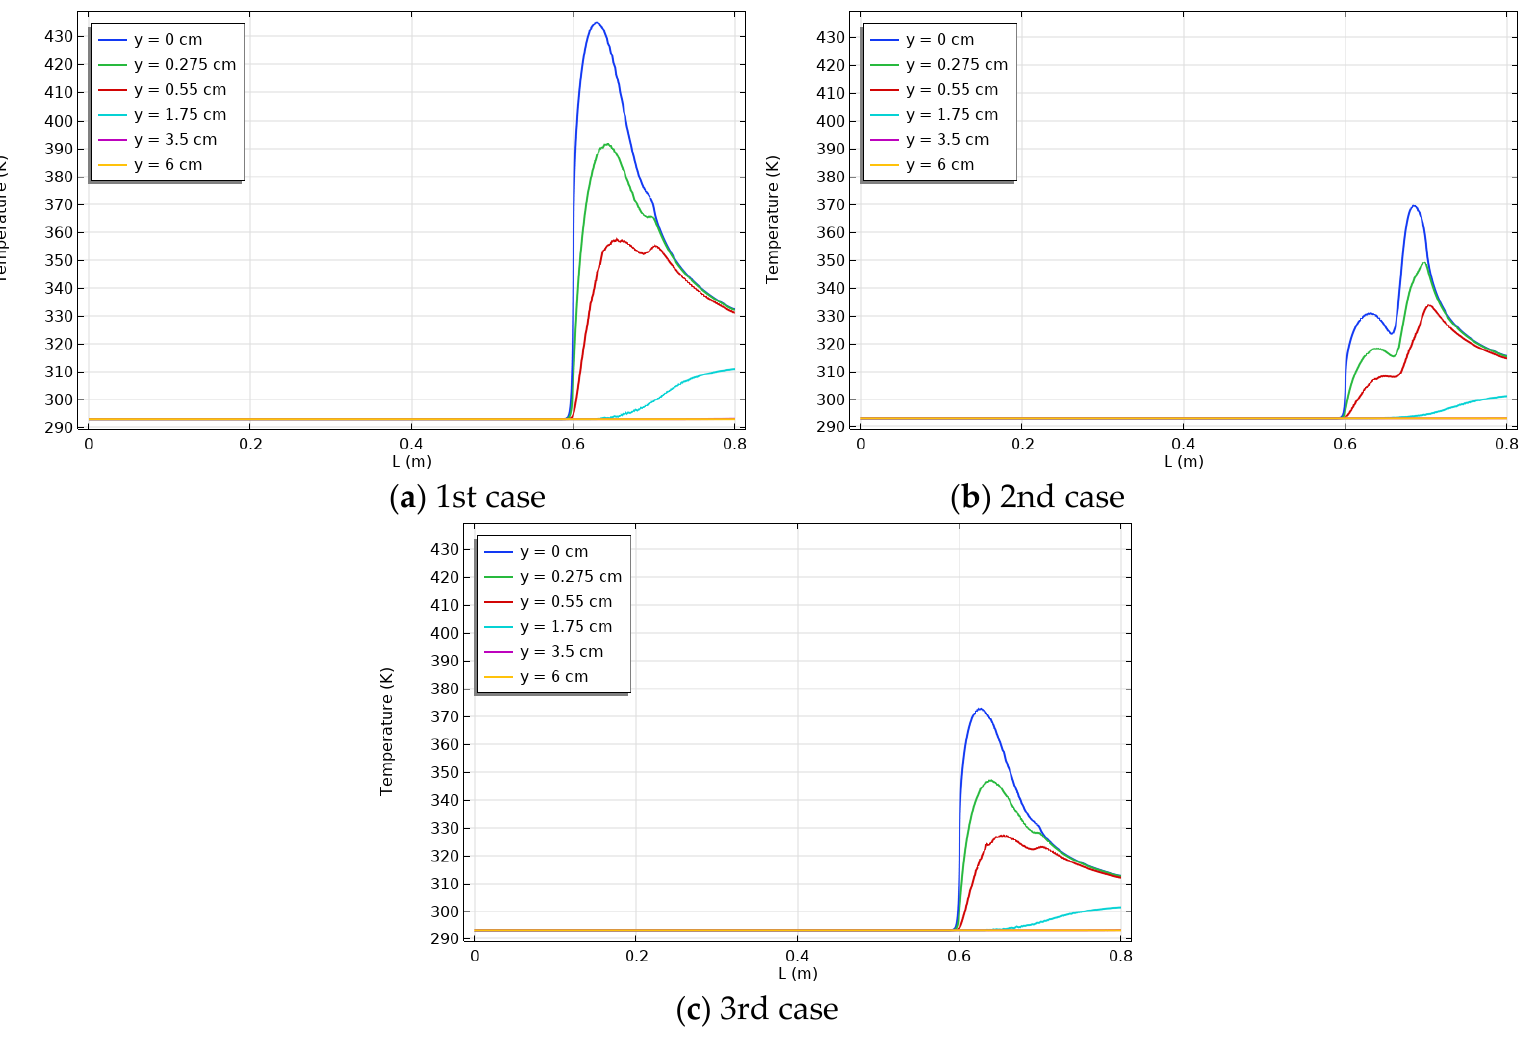
Figure 9. Temperature profile during the positive y axis in the assembly .